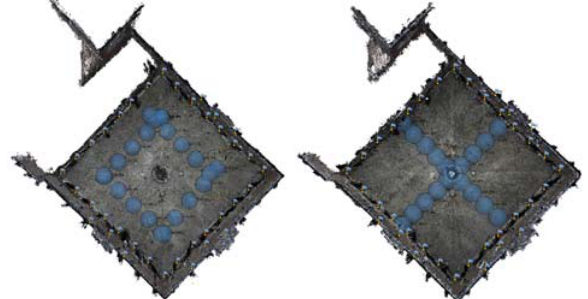
Figure 8. The two acquisition geometry acquired: the “square” (on the left) and the “cross” scheme (on the right).